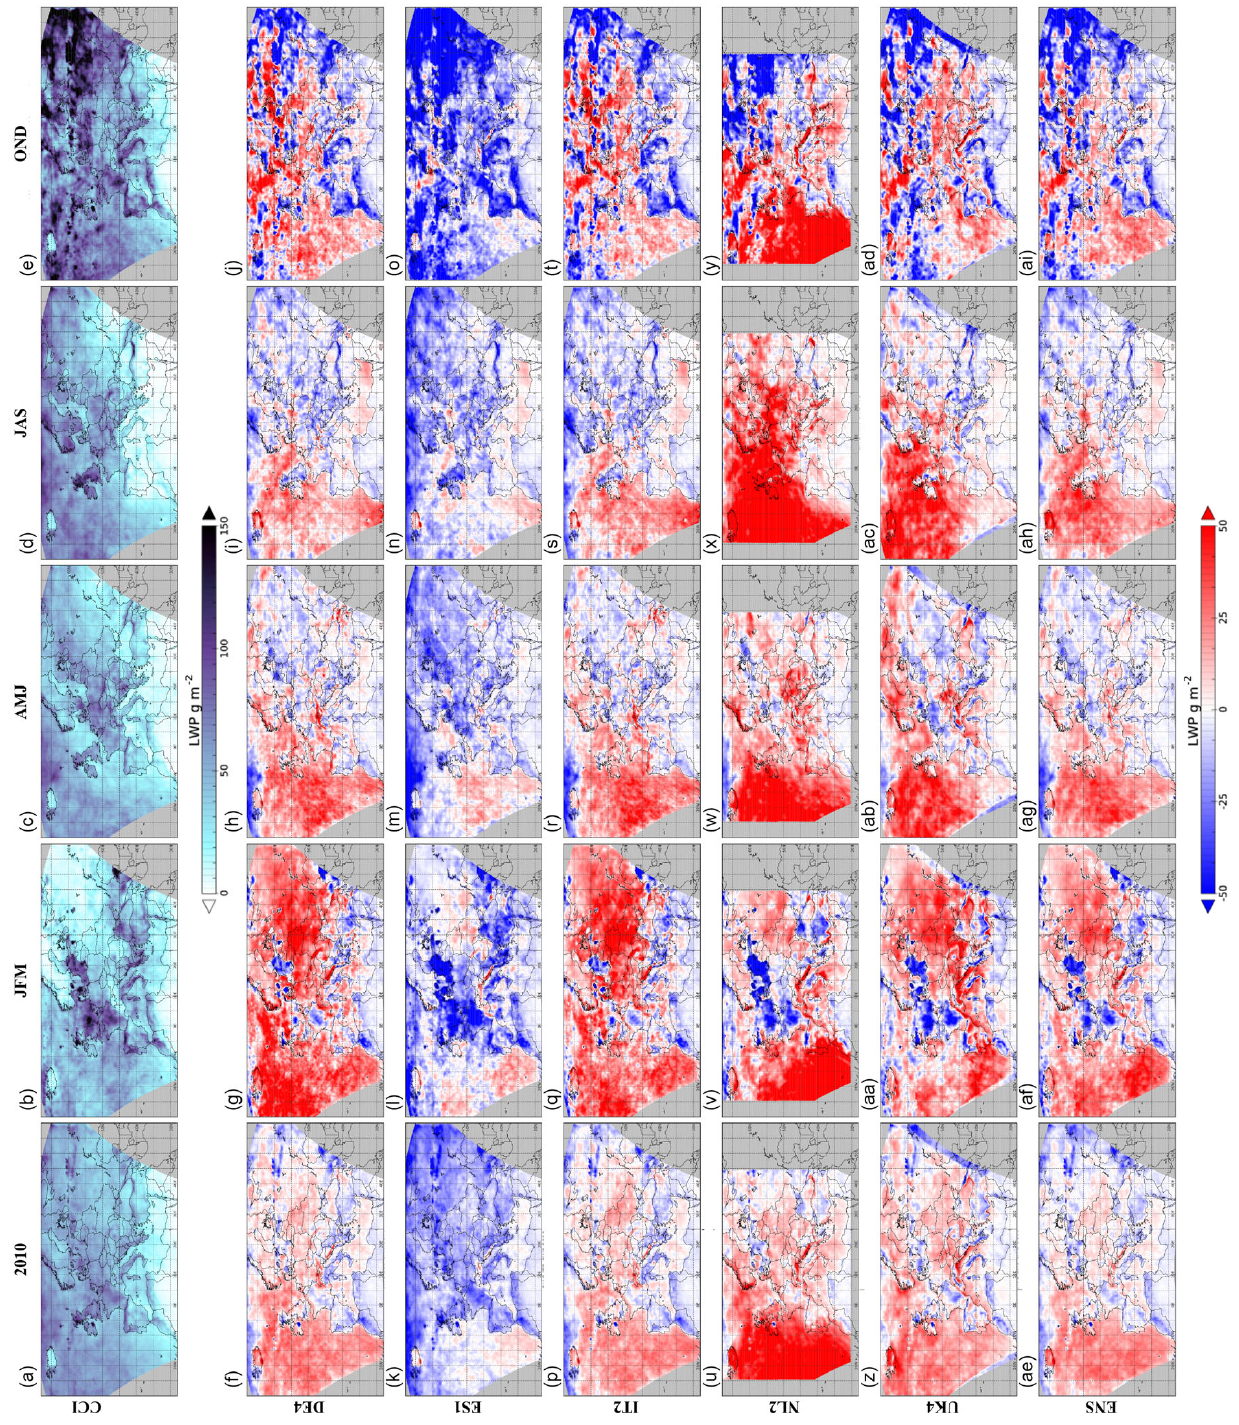
Figure 4. Same as Fig. 1 for the LWP and mean bias error